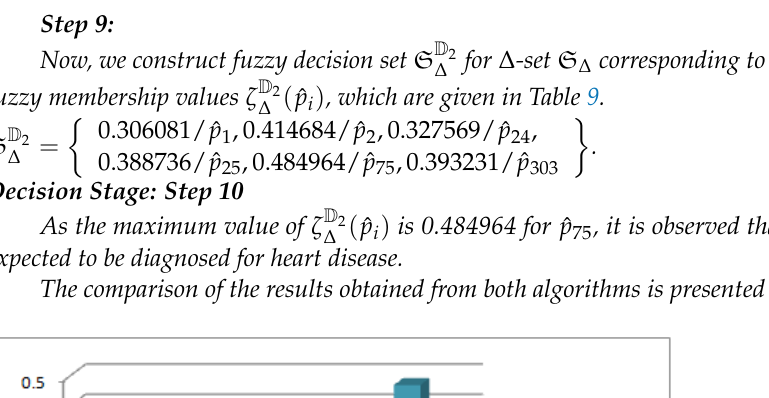
Figure 10. Fuzzy membership ζ